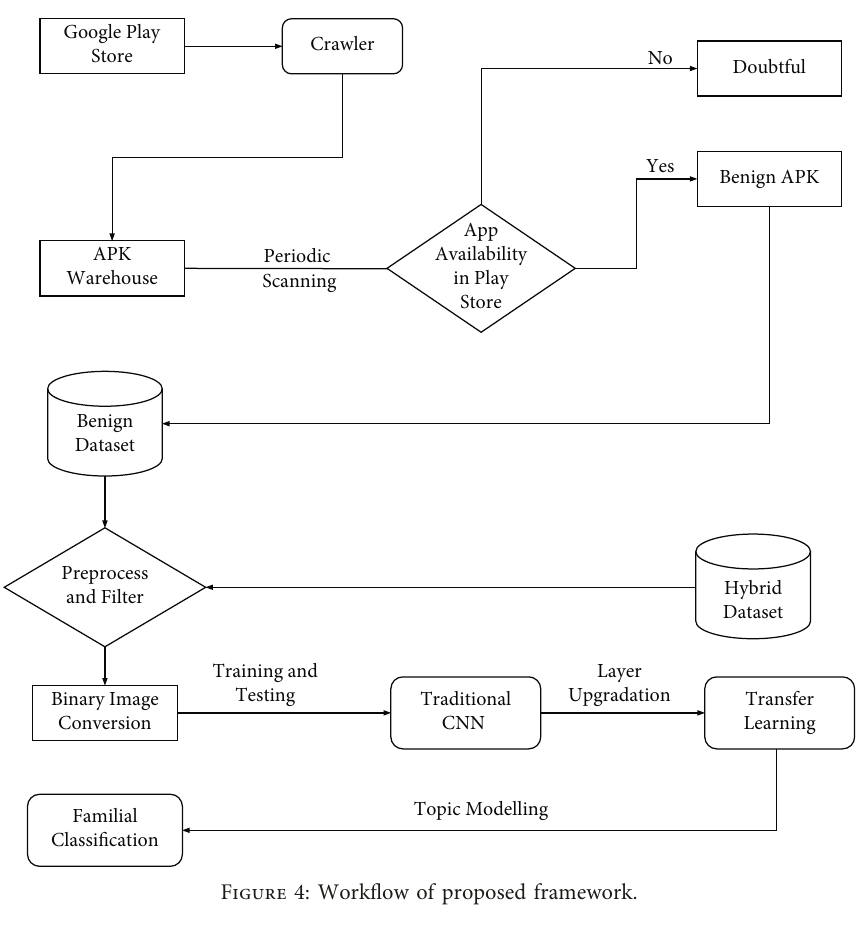
Figure 4: Workflow of proposed framework.